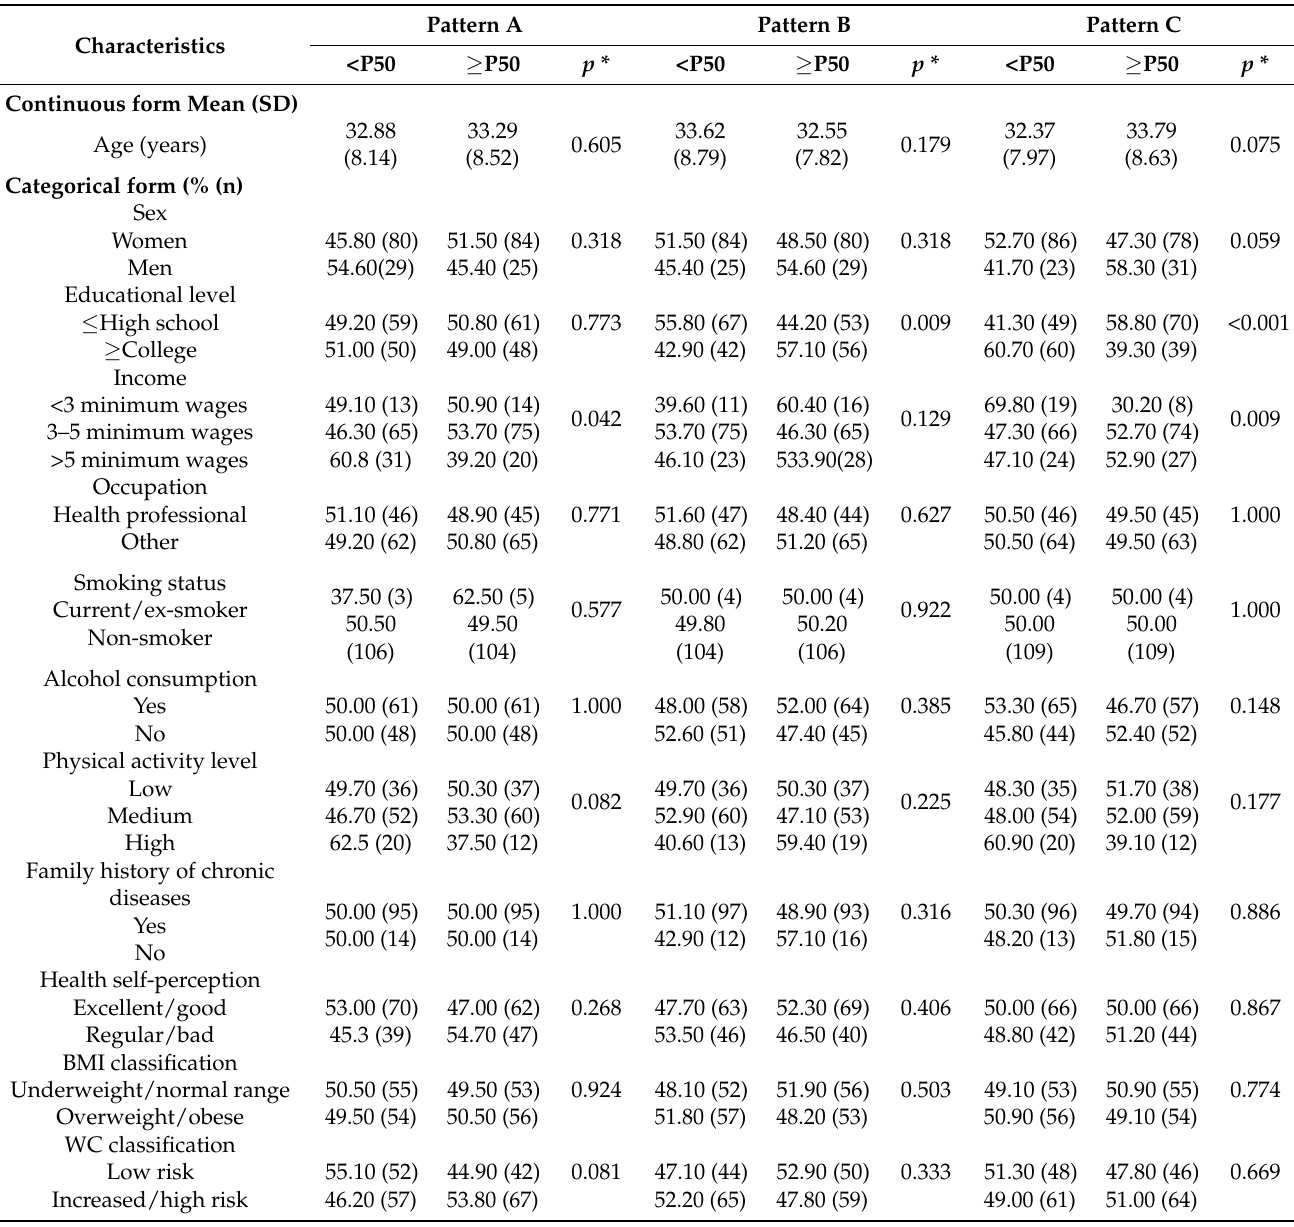
Table 3. Descriptive analysis of the workers’ sociodemographic, lifestyle, and health characteristics, and their associations with the dietary patterns over time. Santo Ant ô nio de Jesus city,